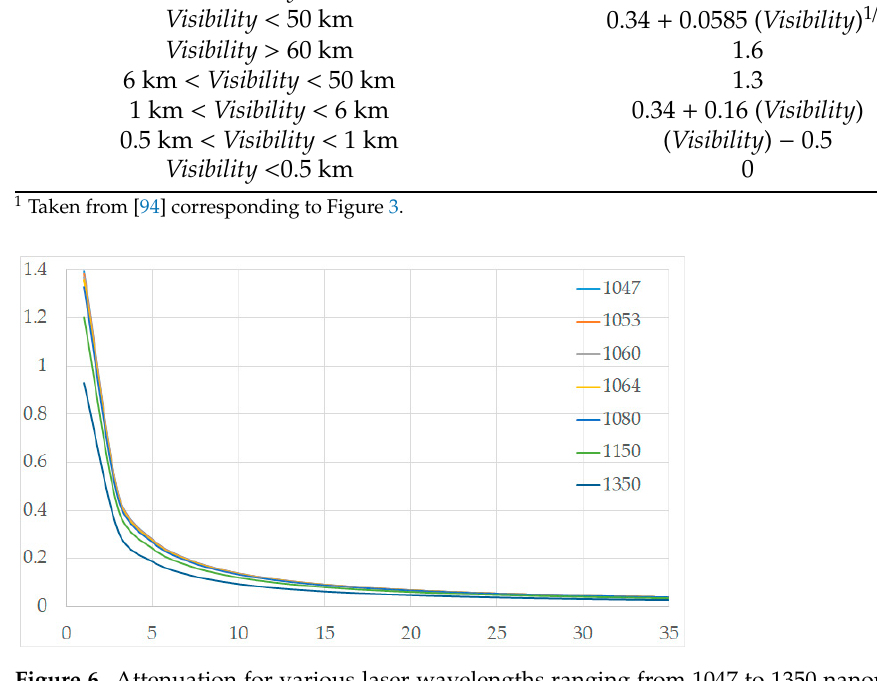
Figure 6. Attenuation for various laser wavelengths ranging from 1047 to 1350 nanometers with visibility range (km) on the abscissa and fog attenuation on the ordinant. Notice in Figure 4 nominally similar attenuation regardless of laser wavelength.